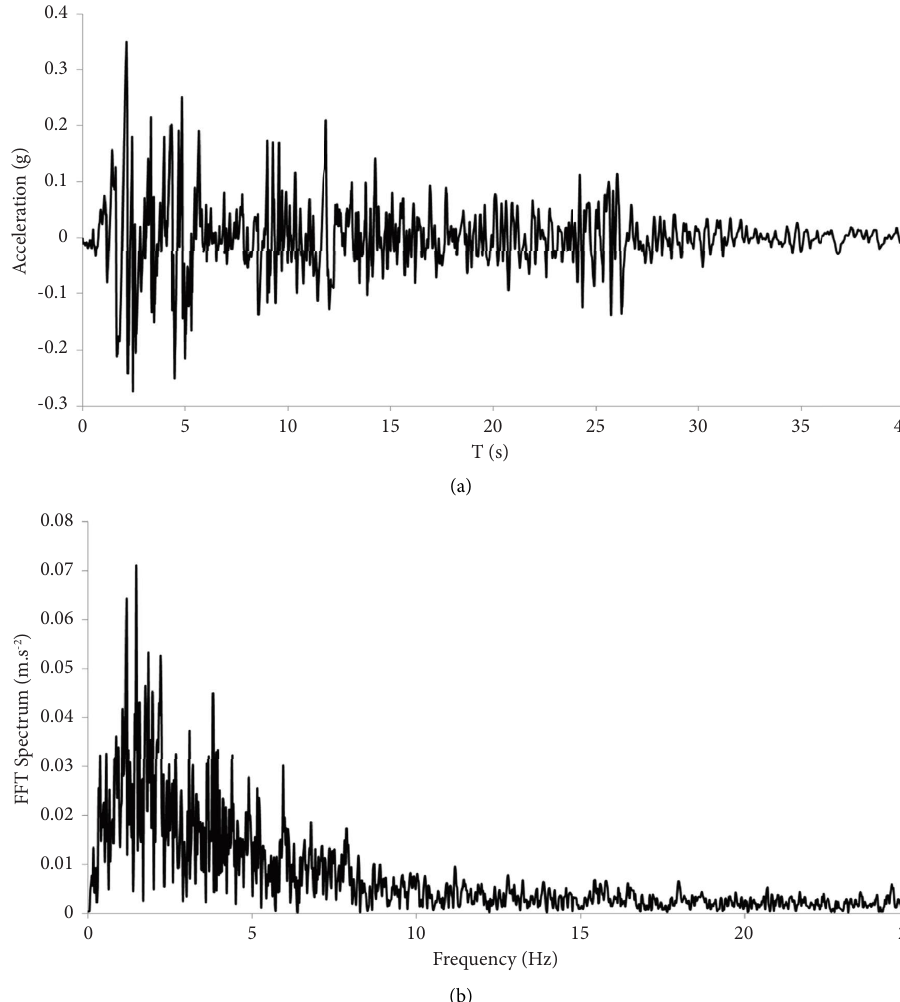
Figure 4: Acceleration time historie and FFT spectra of El Centro earthquake wave: (a) the acceleration time history; (b) the FFT spectra. Table 2: Adjusted amplitudes and the amplifcation coefcients of the input seismic load. Adjusted amplitude 0.15 g Amplifcation coefcients Seismic